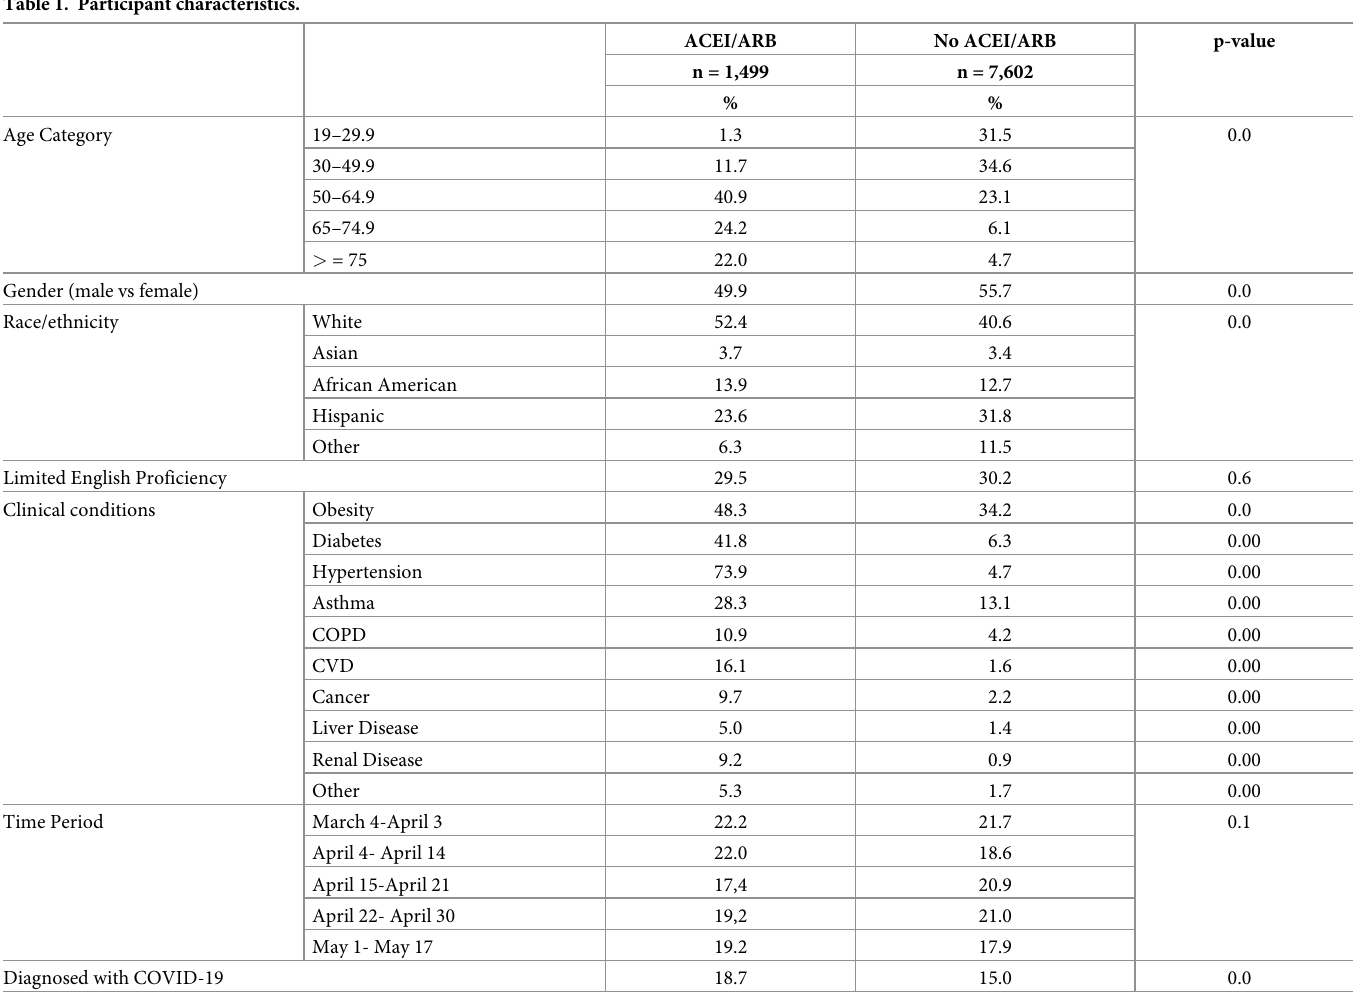
Table 1. Participant